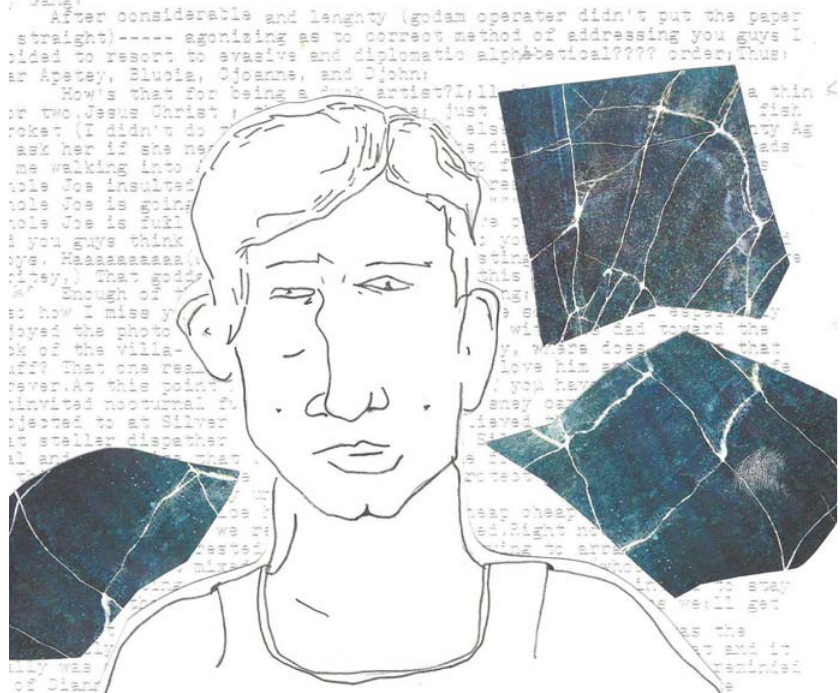
Figure 3. Drawing and collage, with typed letter written by Peter